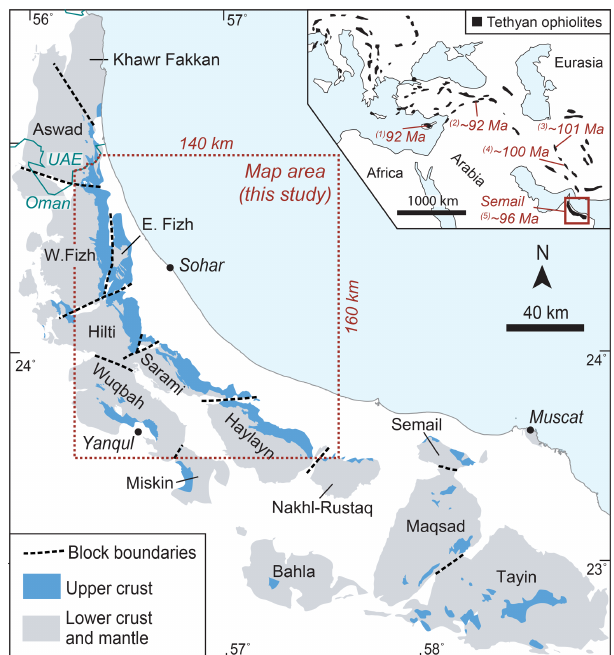
Figure 1. Map of the Semail ophiolite structural blocks simpli- fied after Nicolas et al. (2000) with the additional differentiation of the structurally separate western (W.) and eastern (E.) Fizh blocks, showing the area mapped in this study. Inset: map of Tethyan ophi- olites adapted after Dilek et al. (2007) with U–Pb zircon ages of ini- tial accretion indicated for the Albian–Turonian ophiolite chain of 1 Troodos, 2 Kizildag, 3 Nain, 4 Deshir, and 5 Semail after Shafaii Moghadam et al. (2013) and references